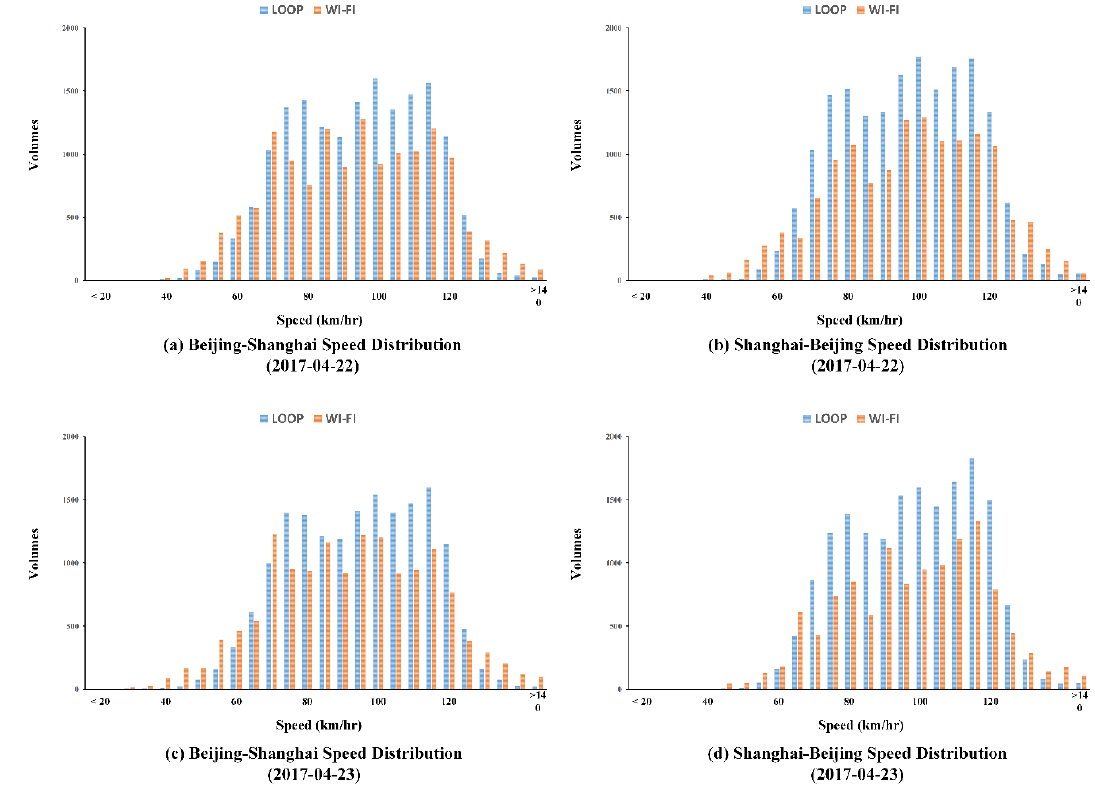
Figure 8. Comparison of speed distributions between the numbers of vehicles and unique MAC addresses (after filtering and mining). ( a ) Speed distribution comparison between loop detector results and Wi-Fi signal based results for Beijing to Shanghai over 22 April 2017, ( b ) Speed distribution comparison between loop detector results and Wi-Fi signal based results for Shanghai to Beijing over 22 April 2017, ( c ) Speed distribution comparison between loop detector results and Wi-Fi signal based results for Beijing to Shanghai over 23 April 2017, ( d ) Speed distribution comparison between loop detector results and Wi-Fi signal based results for Shanghai to Beijing over 23 April 2017.